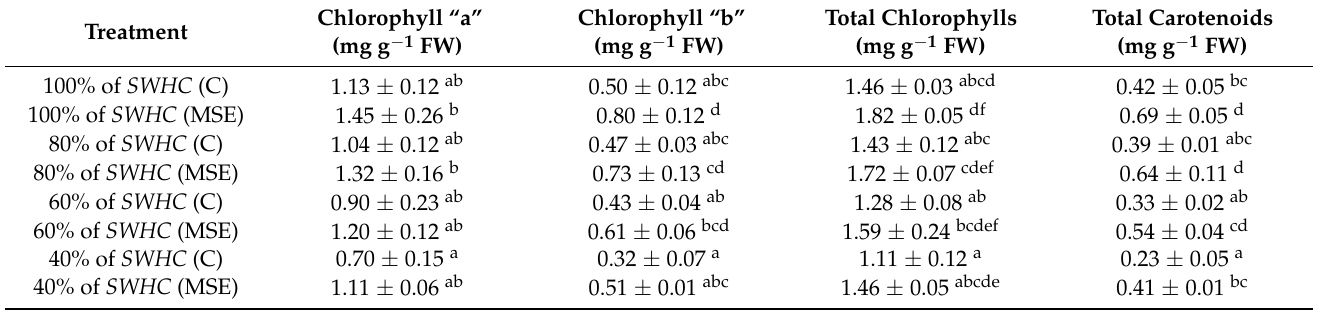
Table 5. Leaf photosynthetic pigments of S. frutescens plants treated with M. oleifera seed extract (MSE) under deficit irrigation